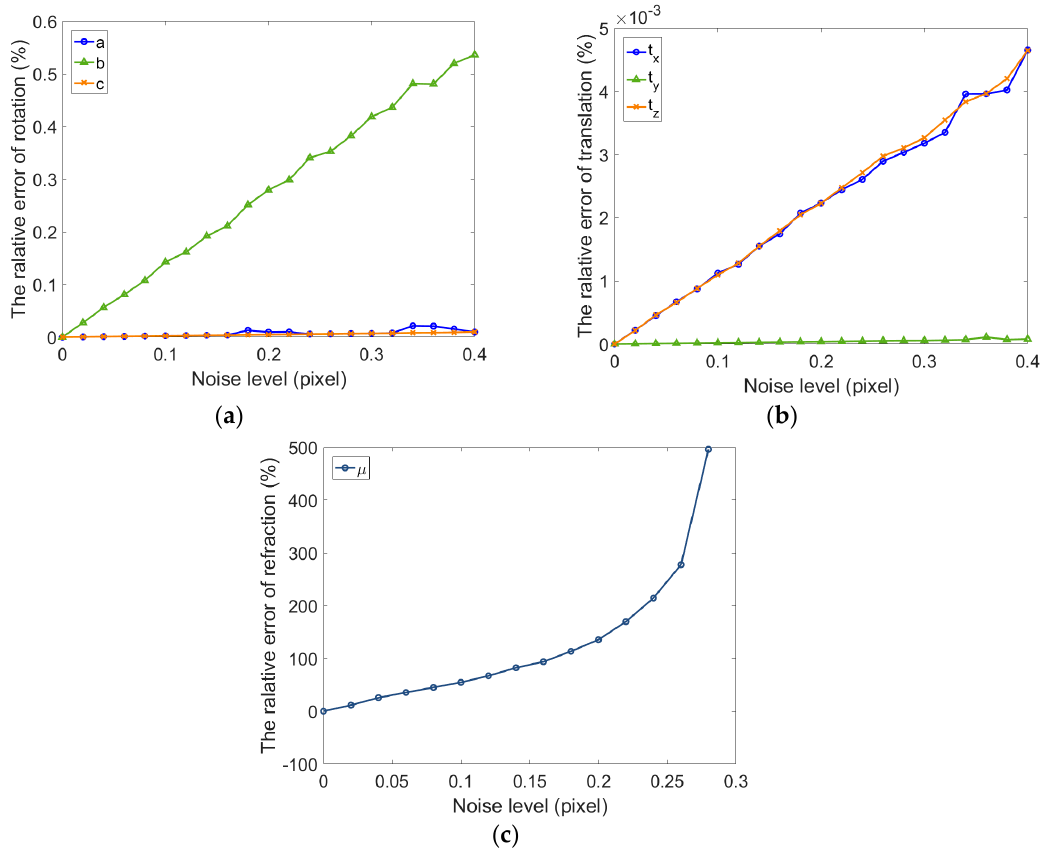
Figure 7. The relative error of extrinsic parameters for one camera with refraction estimation. ( a ) Relative error for the rotation vector; ( b ) Relative error for the translation vector; ( c ) Relative error for the refraction index.